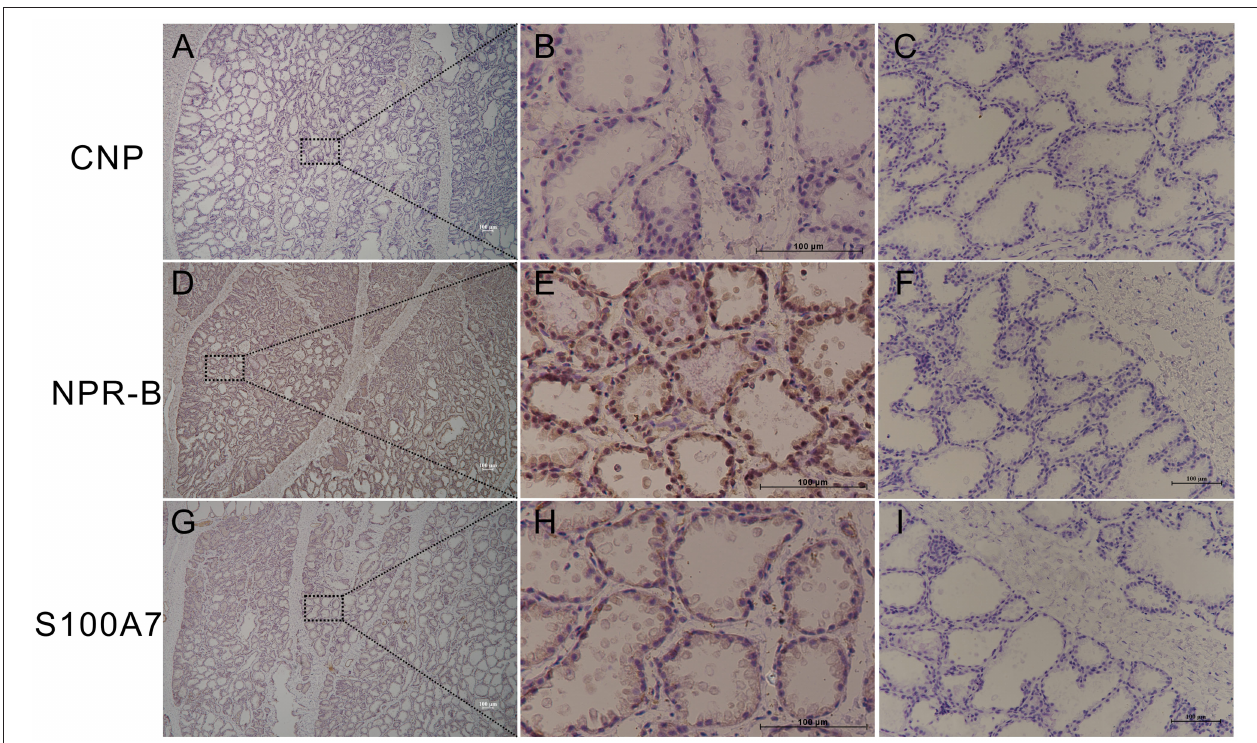
FIGURE 1 | Representative images of immunohistochemistry in healthy goat mammary gland showing the expression of natriuretic peptide receptor B (NPR-B), but not C-type natriuretic peptide (CNP) in alveolus. (A–C) Immunohistochemical results of CNP. (D–F) Immunohistochemical results of NPR-B. (G–L) Immunohistochemical results of S100A7. (C,F,L) Negative control. Bar = 100 µ